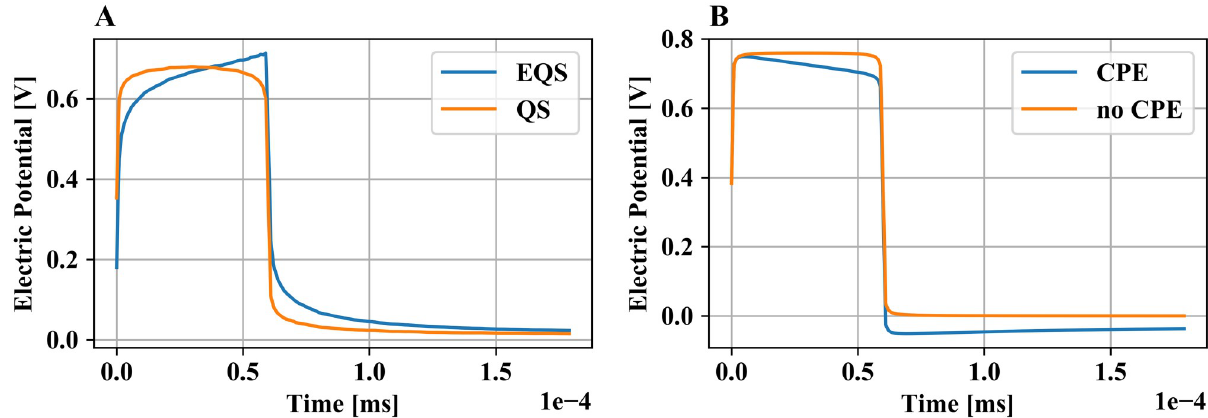
Fig 9. Electric potential distribution on a single axonal compartment during DBS with different computational models. (A) Current-controlled stimulation in the rat model, computed with the EQS and the QS formulations, both without CPE. The difference arises from the capacitive charging in the former formulation. (B) Voltage-controlled stimulation with and without CPE in human model for the EQS formulation. The shape of the potential is affected by the high impedance of the electrical double layer at low frequencies.